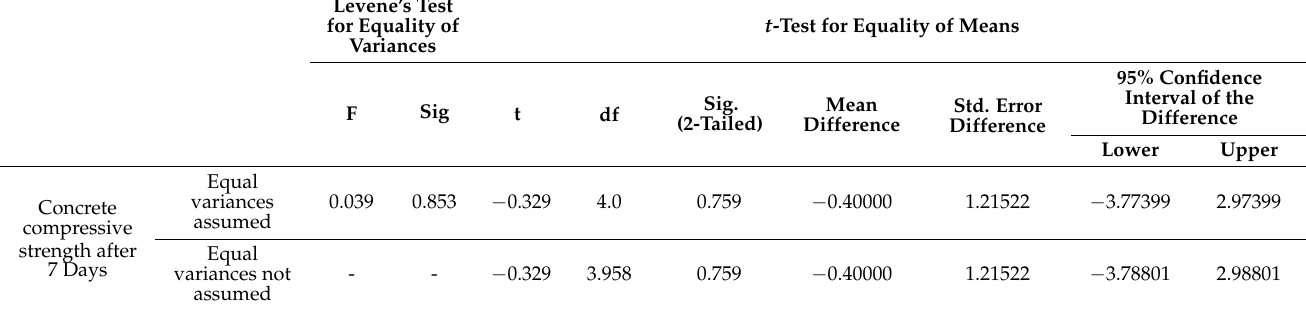
Table 9. Independent t -test for concrete compressive strength after 7